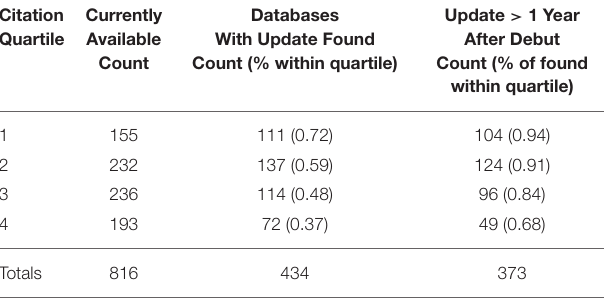
TABLE 2 | Updates found for currently available